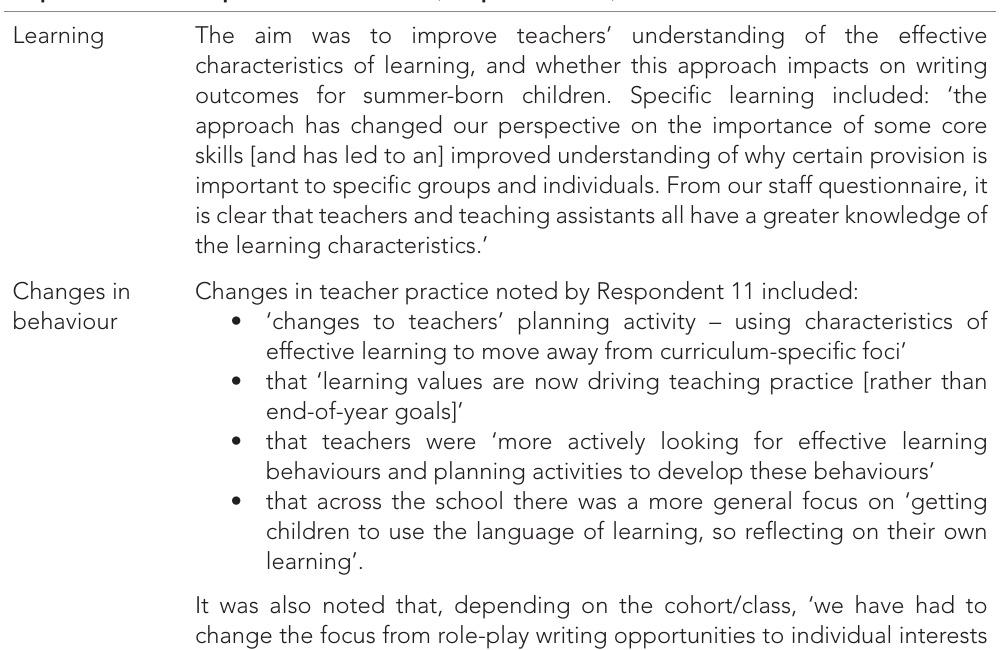
Table 3: An example of one respondent’s impact statement Impact domain Impact text and data (Respondent